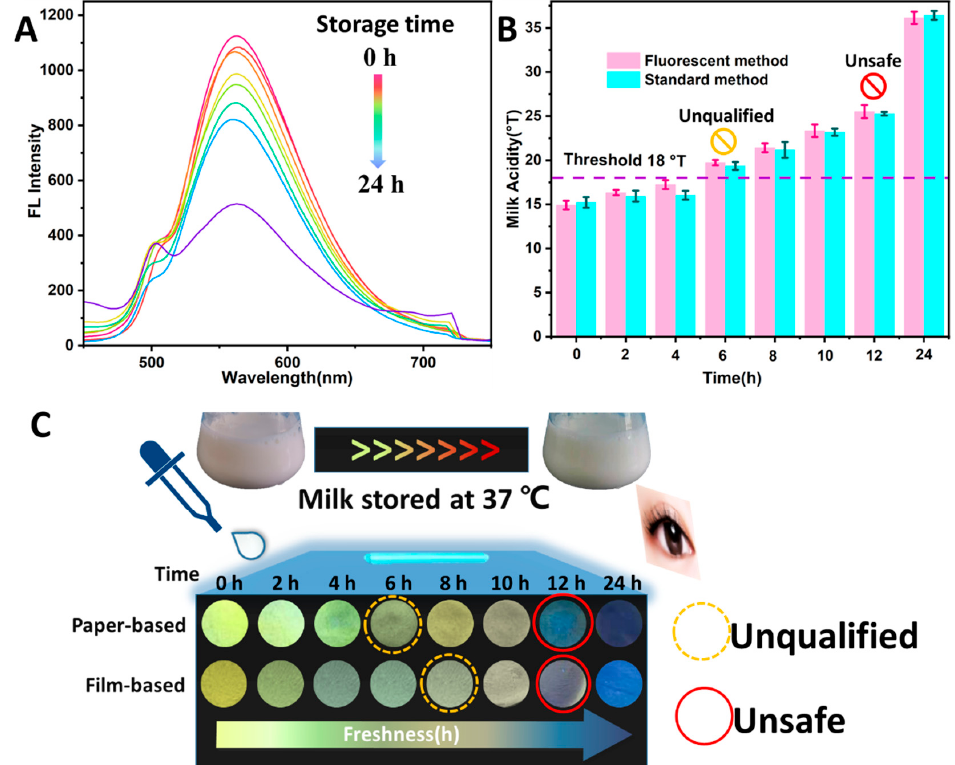
Figure 6. ( A ) Fluorescence spectra of N-CQDs in the presence of milk at different storage times; ( B ) Milk acidity during storage detected by the fluorescence method (pink bars) and standard method (blue bars), Purple dot line represented the milk freshness threshold set in national standard; ( C ) Monitoring milk freshness over different storage times by fluorescence sensors.